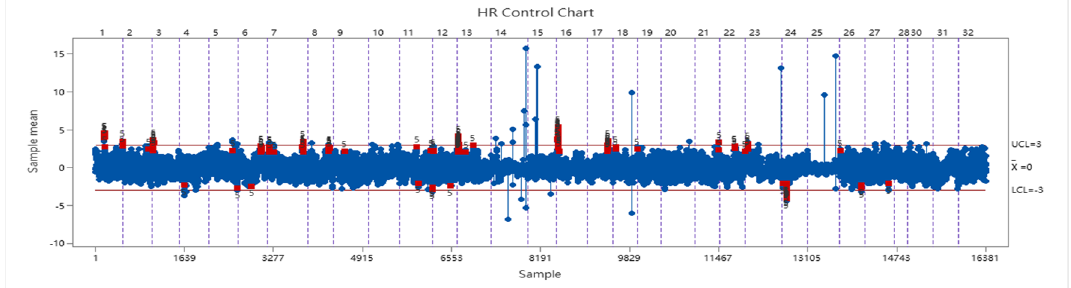
Figure 13. Shewhart control chart of standardized heart rate data.